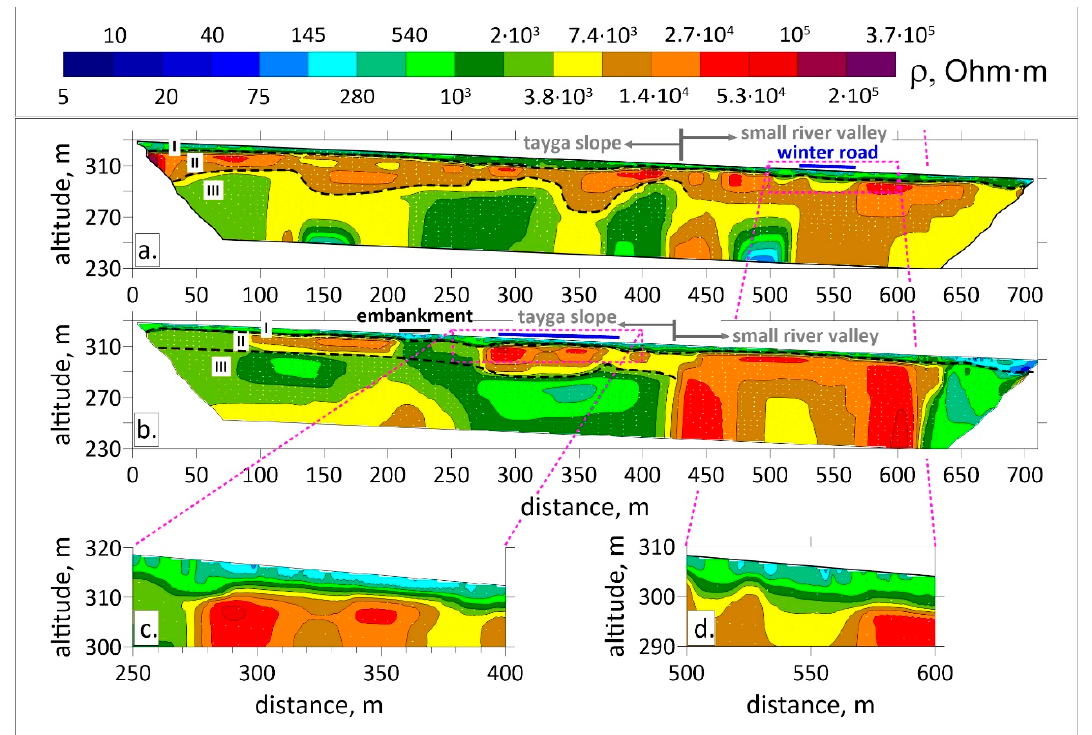
Figure 5. Inverted resistivity section (Ohm ⋅ m) along profile 1 ( a ) and 4 ( b ), and their large-scale insets within winter road cross segments ( c , d ). Complete pole–dipole measurements. White dots are resistivity data points used in inversion.